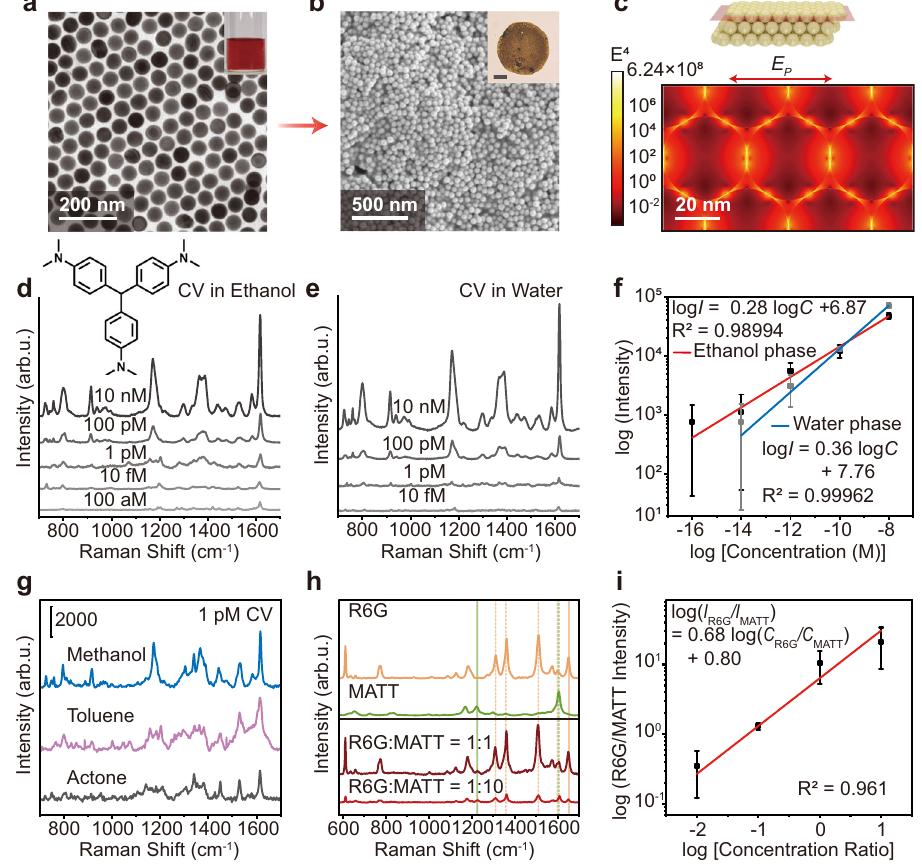
Fig. 2 | Sensitive SERS detection in various liquids using the DLE platform. a Transmission electron microscope image of the Au nanospheres. Inset: Photo- graphy of the Au nanosphere colloidal dispersion. b Simultaneous enrichment of AunanospheresandCVmolecules.Inset:MicroscopyimageoftheAunanosphere/ CV molecule aggregate.Scale bar: 100 µ m. c FDTD simulatedelectromagnetic fi eld distribution over the Au nanosphere aggregate. d , e SERS spectra of CV molecules concentrated from ethanol solution and aqueous solution, respectively, with dif- ferent starting concentrations. Inset in d : Molecularstructure of CV. f Relationship